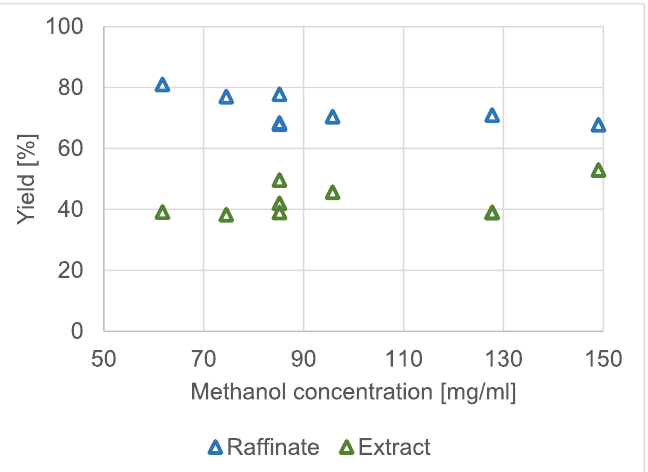
Figure 6. The effect of the concentration of methanol in the autoclave during the recrystallization of racemic benzylammonium mandelate.